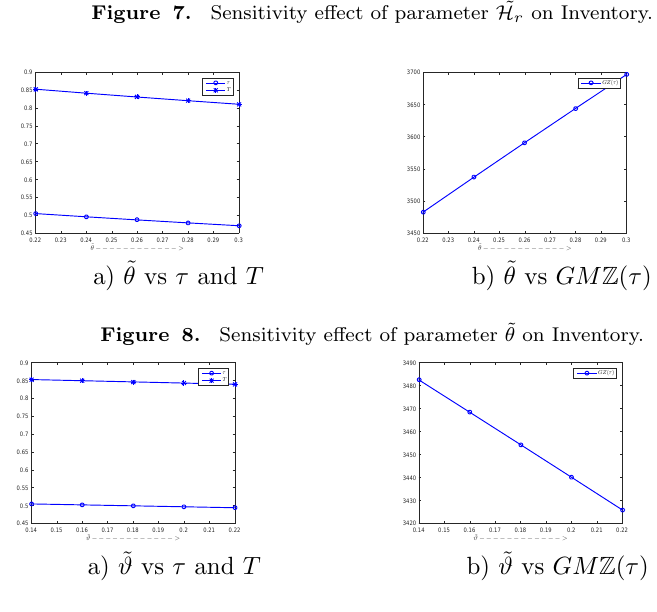
Figure 9. Sensitivity effect of parameter ˜ ϑ on